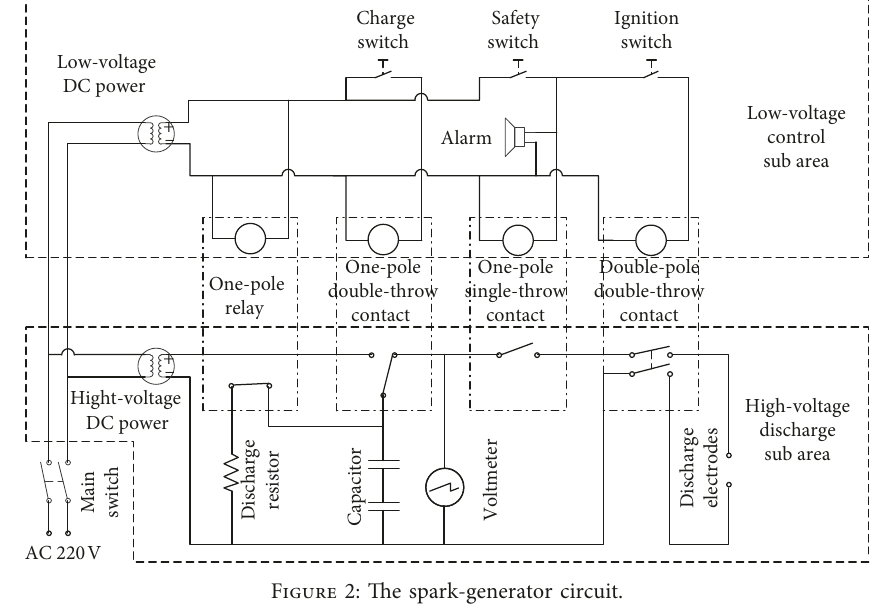
Figure 2: The spark-generator circuit.